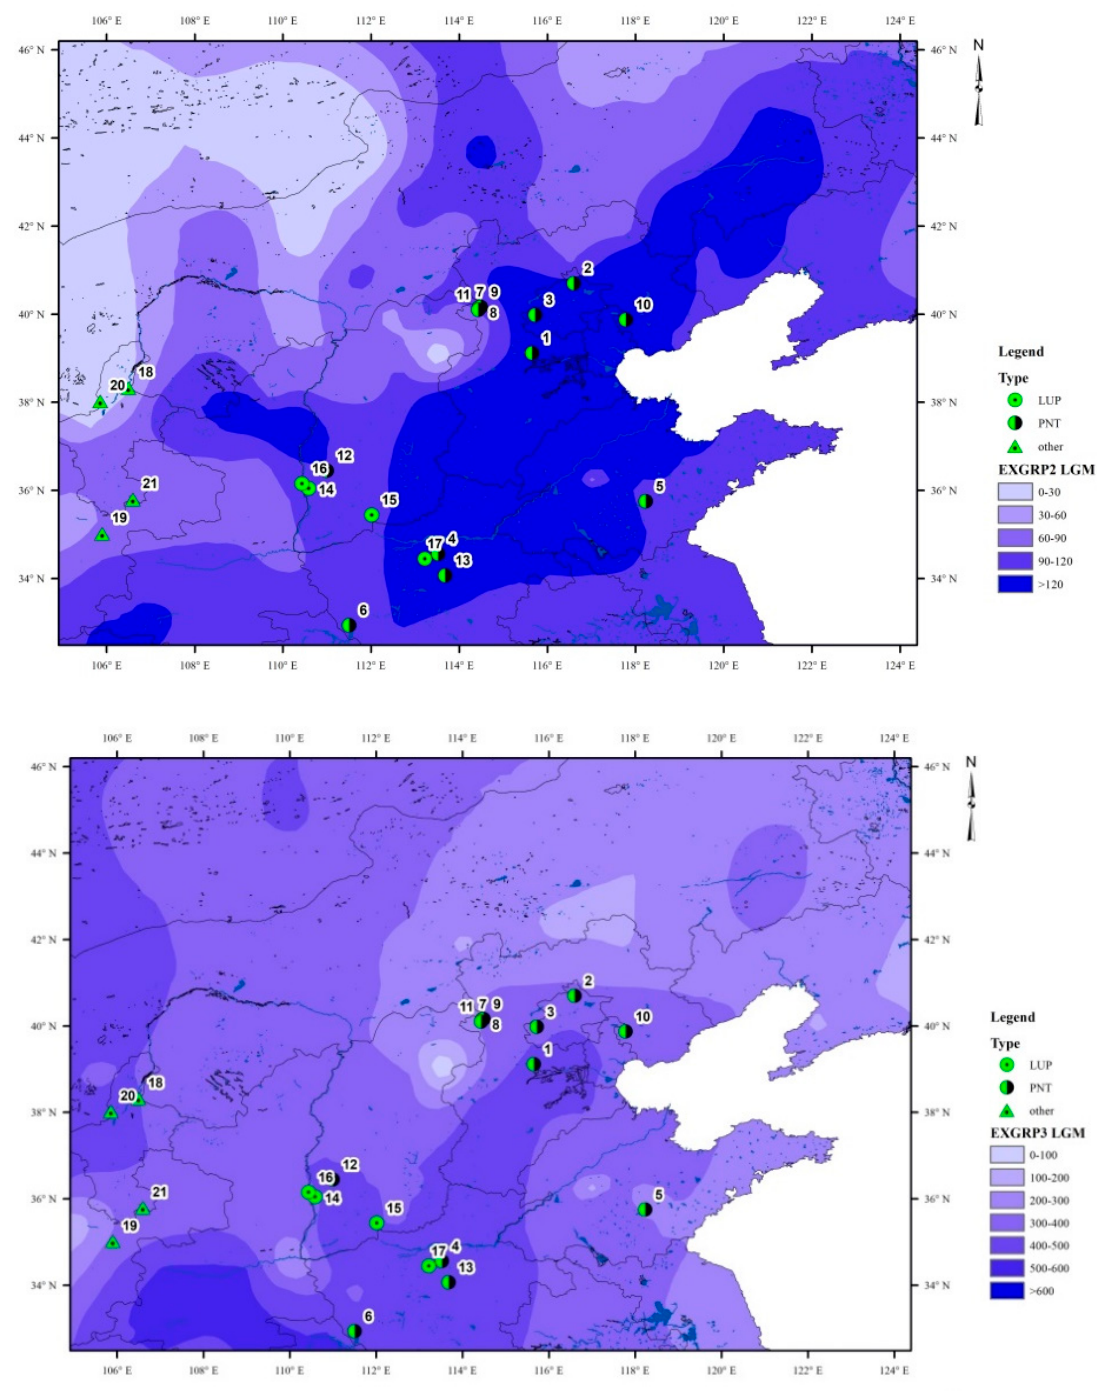
Figure 10. Archaeological sites dated to the Pleistocene to Holocene transition on the maps of expected hunter–gatherer group size in northern China under LGM climatic conditions.